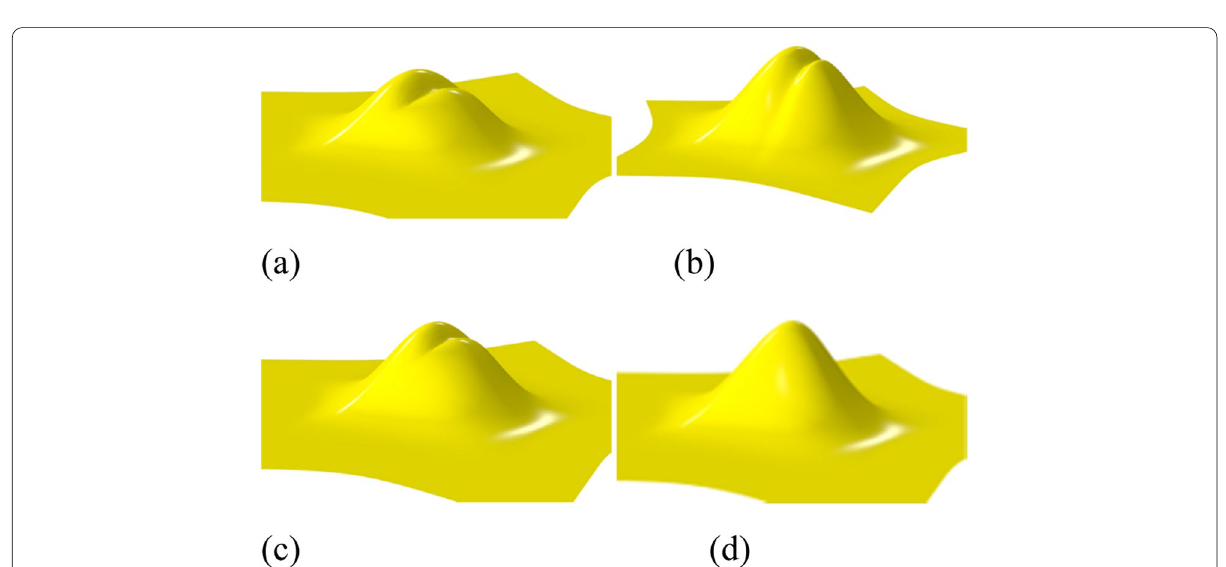
Fig. 2 Limit surfaces generalized using a NURSS in ref. [2], b the scheme in ref. [4], c the rule in ref. [6], and d the newly developed